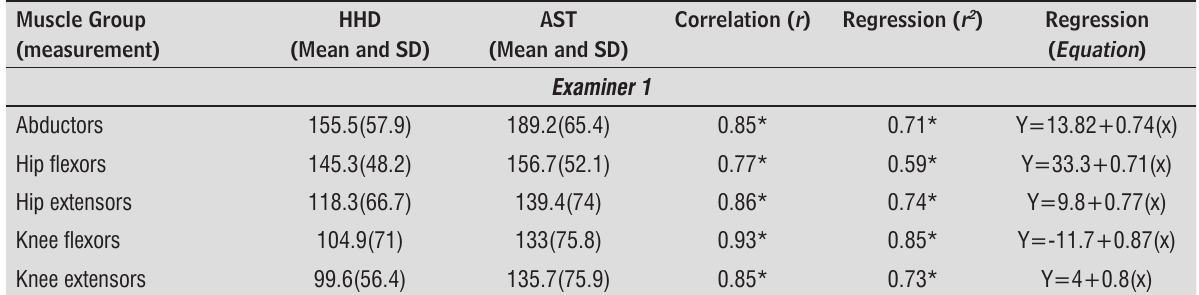
Table 3 - Descriptive statistics (mean ± SD), Pearson’s correlation coefficient and regression analysis (r 2 ) of the first force repetition, presenting data from examiners 1 and 2, on the first day of evaluation, n =